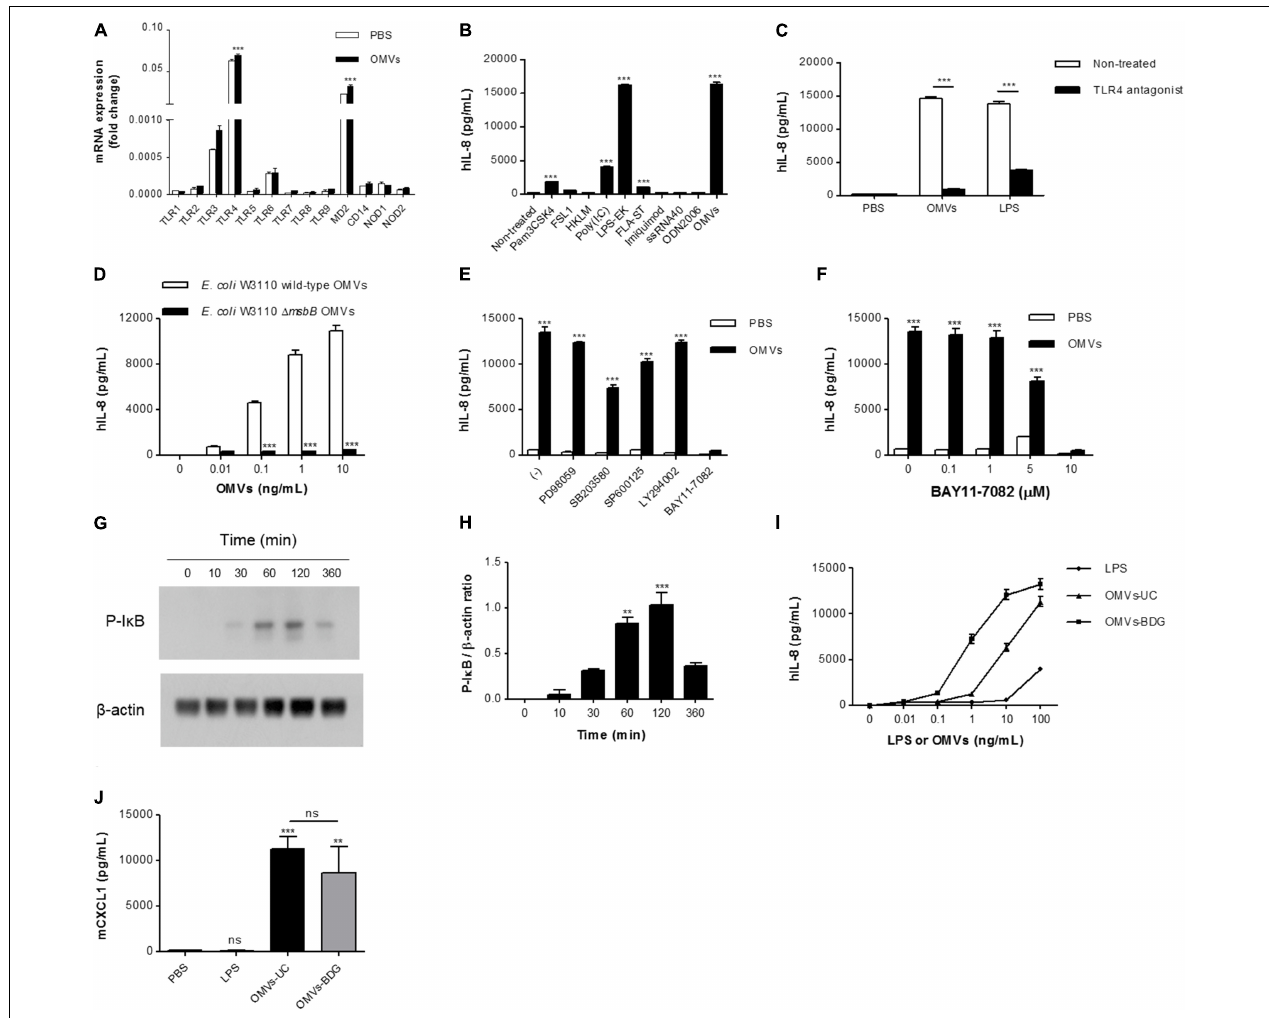
FIGURE 4 | The roles of TLR4 and NF- κ B in IL-8 release from OMV-stimulated endothelial cells. (A) Total RNA was isolated from HMEC-1 treated with PBS or E. coli OMVs (0.5 ng/mL) for 12 h, and mRNA expression of TLRs (TLR1–TLR9), MD2, CD14, NOD1, and NOD2 were analyzed by real-time RT-PCR ( n = 3). Fold changes were calculated by dividing the expression of each gene by that of GAPDH. (B) HMEC-1 was treated with E. coli OMVs (0.5 ng/mL in total protein concentration) or TLR agonists for 12 h, and the concentrations of IL-8 were quantified in the culture supernatants by ELISA ( n = 3). Human TLR agonists were used as follows: TLR1/2 agonist, Pam 3 CSK 4 , 100 ng/mL; TLR2/6 agonist, FSL1, 100 ng/mL; TLR2 agonist, HKLM, 10 7 cells/mL; TLR3 agonist, poly (I:C), 1 µ g/mL; TLR4 agonist, LPS-EK, 10 ng/mL; TLR5 agonist, FLA-ST, 100 ng/mL; TLR7 agonist, imiquimod, 100 ng/mL; TLR8 agonist, ssRNA40, 10 ng/mL; and TLR9 agonist, ODN2006, 500 nM. (C) PBS, E. coli OMVs (10 ng/mL in total protein concentration), or LPS-EK (10 ng/mL) were treated to HMEC-1, with or without TLR4 antagonist (1 µ g/mL) for 12 h, and the concentrations of IL-8 were measured in the culture supernatants by ELISA ( n = 3). (D) Various concentrations (0, 0.01, 0.1, 1, and 10 ng/mL in total protein concentrations) of E. coli W3110 wild-type OMVs or E. coli W3110 (cid:49) msbB mutant OMVs were treated to HMEC-1 for 12 h, and the concentrations of IL-8 were measured in the culture supernatants by ELISA. (E) PBS or E. coli OMVs (0.5 ng/mL in total protein concentration) were treated to HMEC-1 for 12 h with 0.05% dimethyl sulfoxide (–) or the following signaling inhibitors (final concentration = 10 µ M in 0.05% dimethyl sulfoxide): PD98059 (ERK1/2 inhibitor), SB203580 (p38 MAPK inhibitor), SP600125 (JNK inhibitor), LY294002 (PI3K inhibitor), and BAY11-7082 (NK- κ B inhibitor), and the concentrations of IL-8 were measured in the